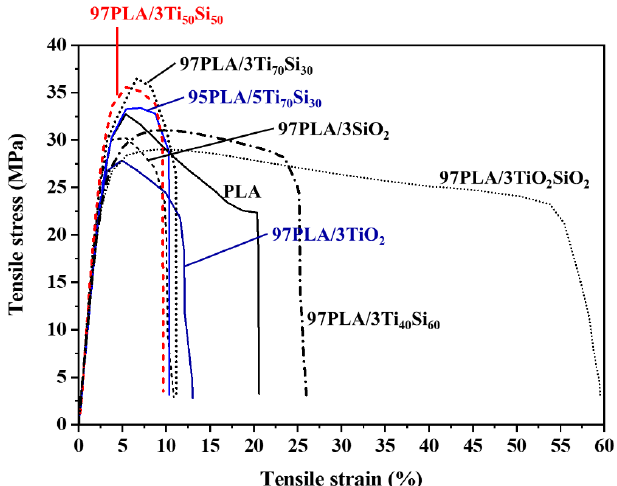
Figure 3. Stress–strain curves of PLA, PLA/TiO 2 , PLA/SiO 2 , PLA/Ti x Si y , and PLA/TiO 2 SiO 2 composites.